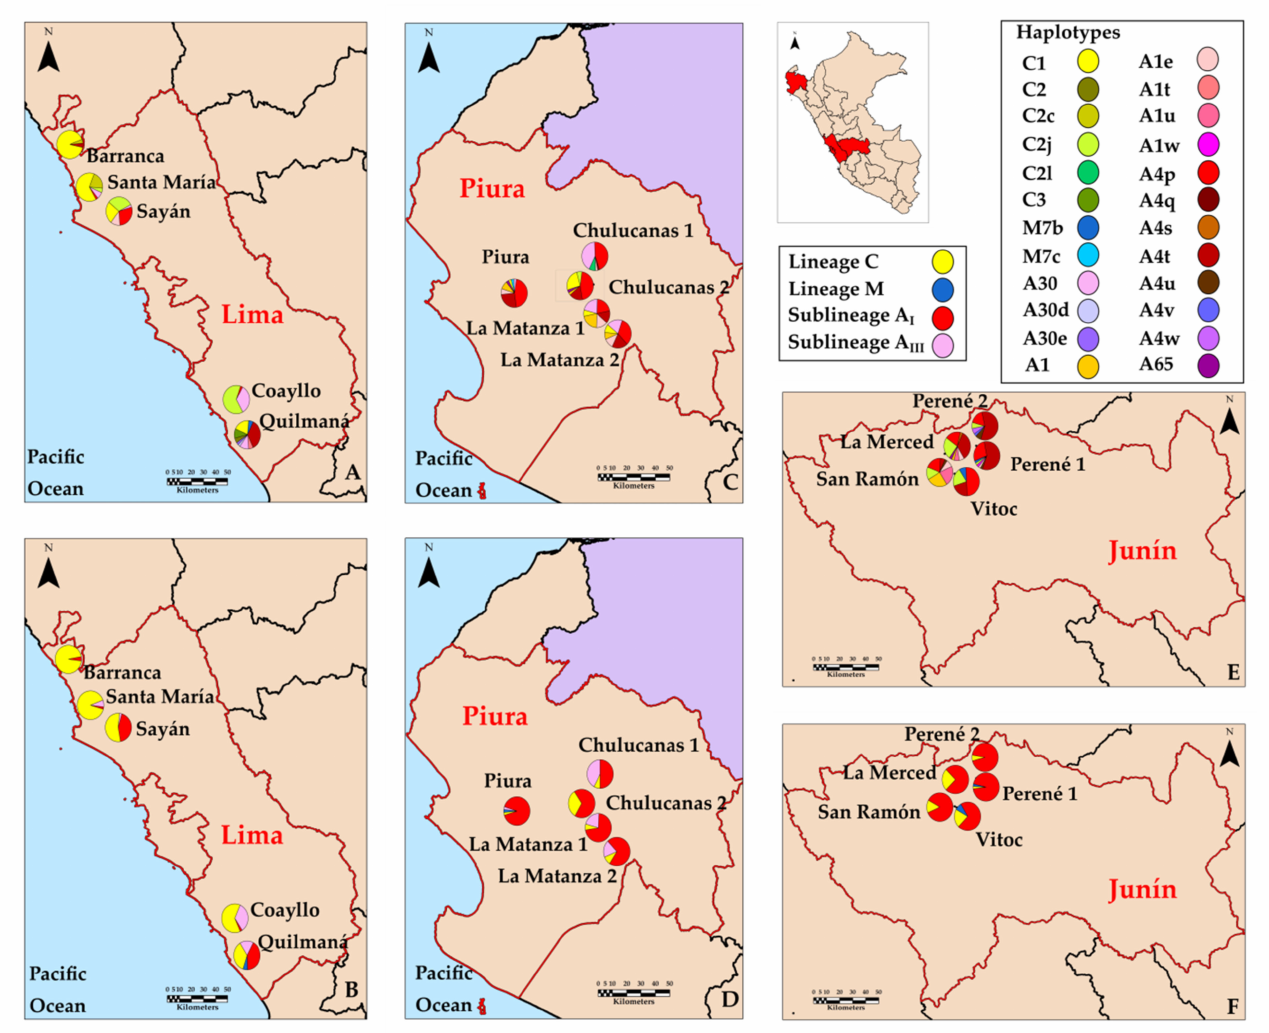
Figure 1. Sampling sites in three regions from Peru. Pie charts display the proportions of haplotypes ( A , C , E ), and evolutionary lineages and sub-lineages ( B , D , F ) for Peruvian honey bee